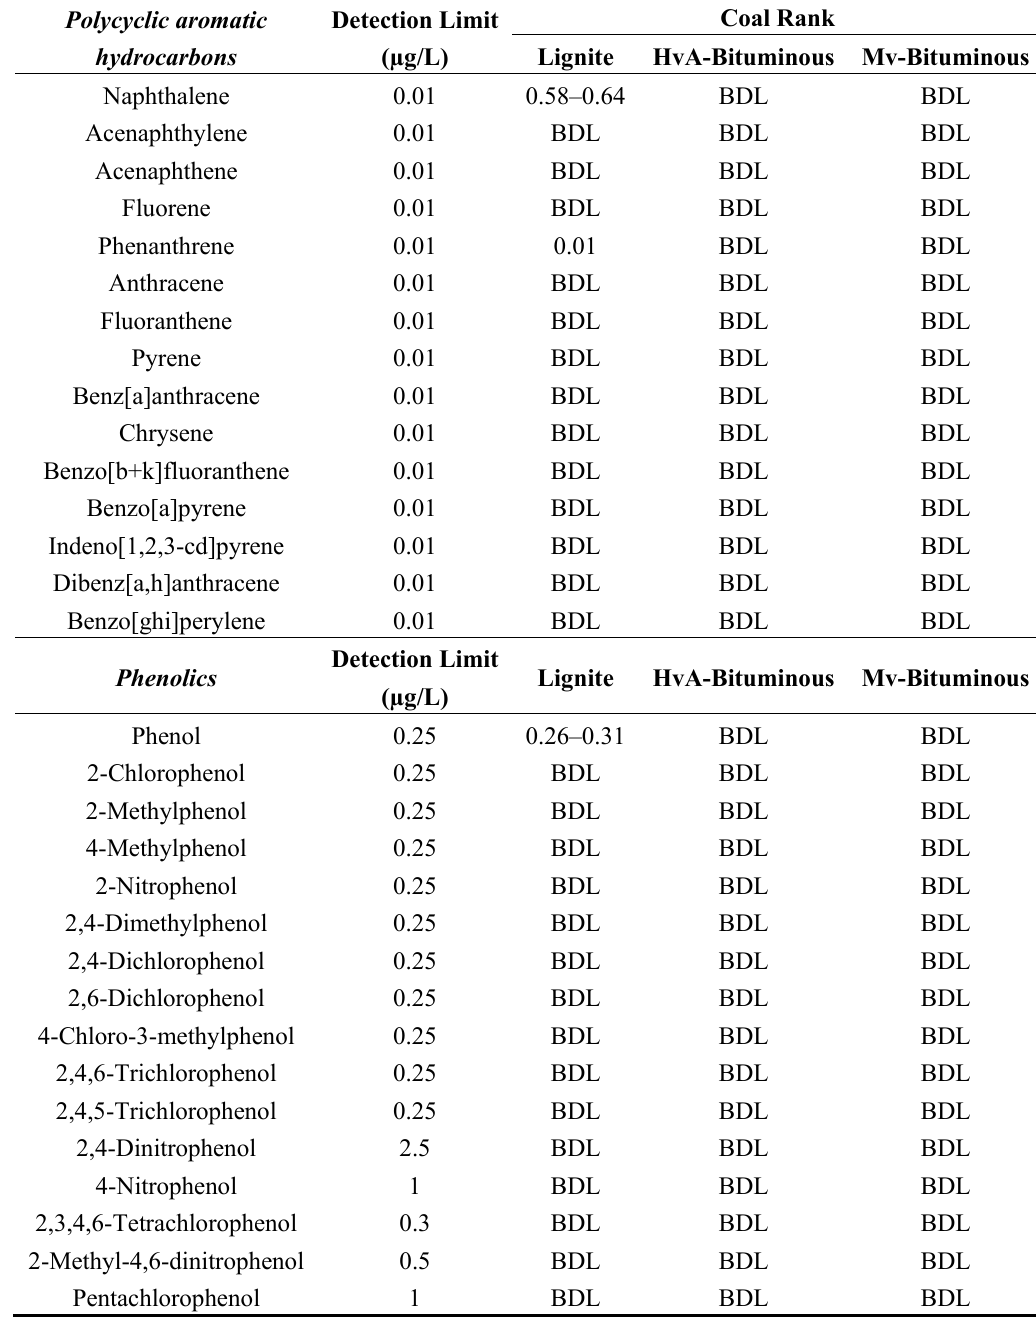
Table 5. Concentration ranges of selected organics from TCLP experiments performed with synthetic CSG